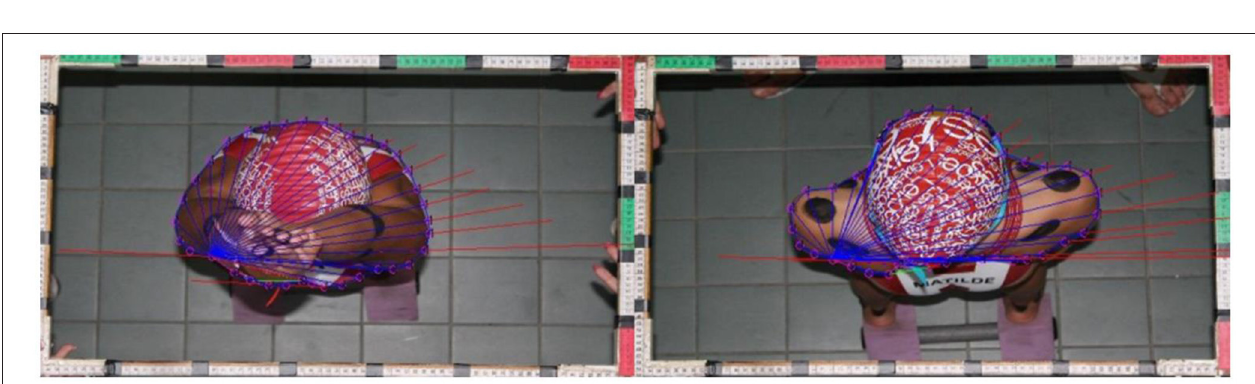
FIGURE 4 | Body surface area determined through planimetry: data processing of the first and second gliding positions.